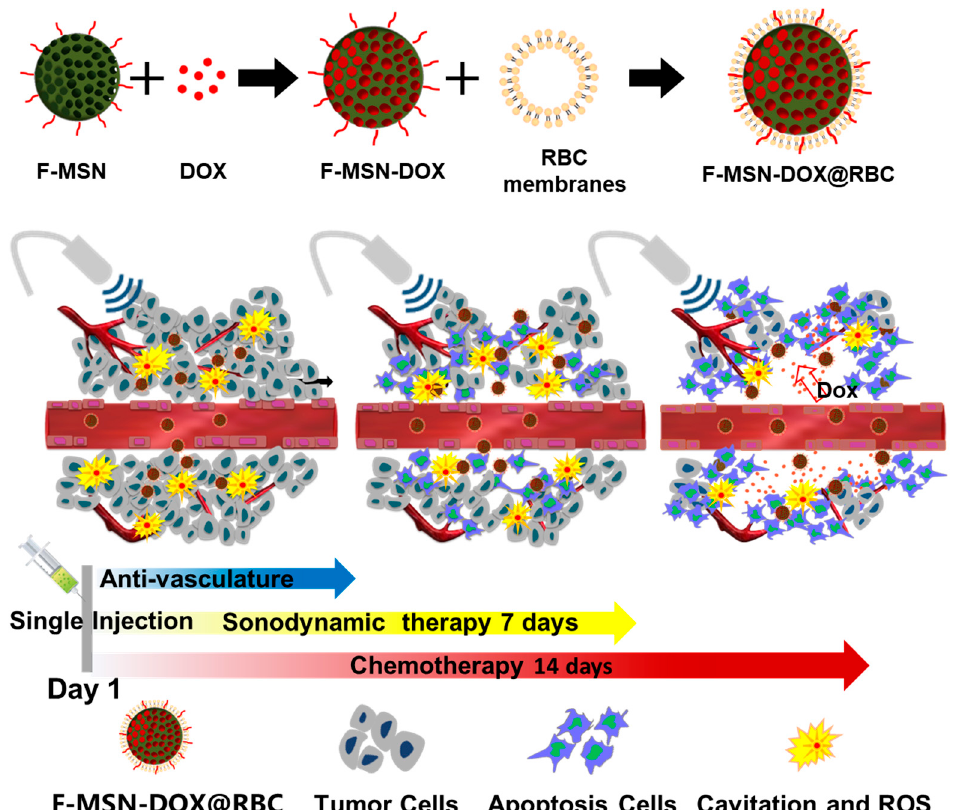
Figure 1. Schematic diagram of the behavior of DOX-loaded superhydrophobic MSN (F-MSN-DOX) with RBC membranes (F-MSN-DOX@RBC). An illustration of the therapeutic process used to treat the tumor by acoustic cavitation and sonodynamic therapy and chemotherapy concurrently using a single dose injection of F-MSN-DOX@RBC.